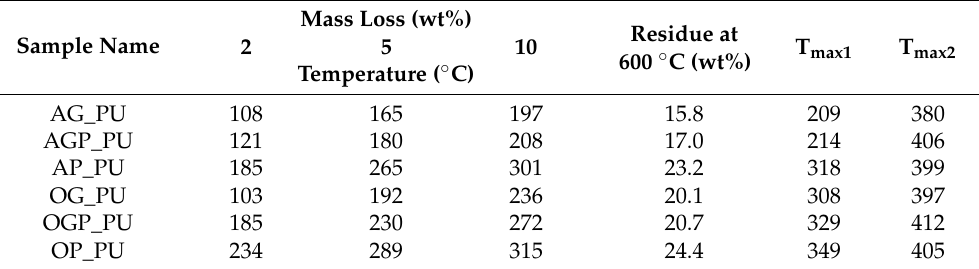
Table 5. Characteristics of thermal degradation of the polyurethane resins.